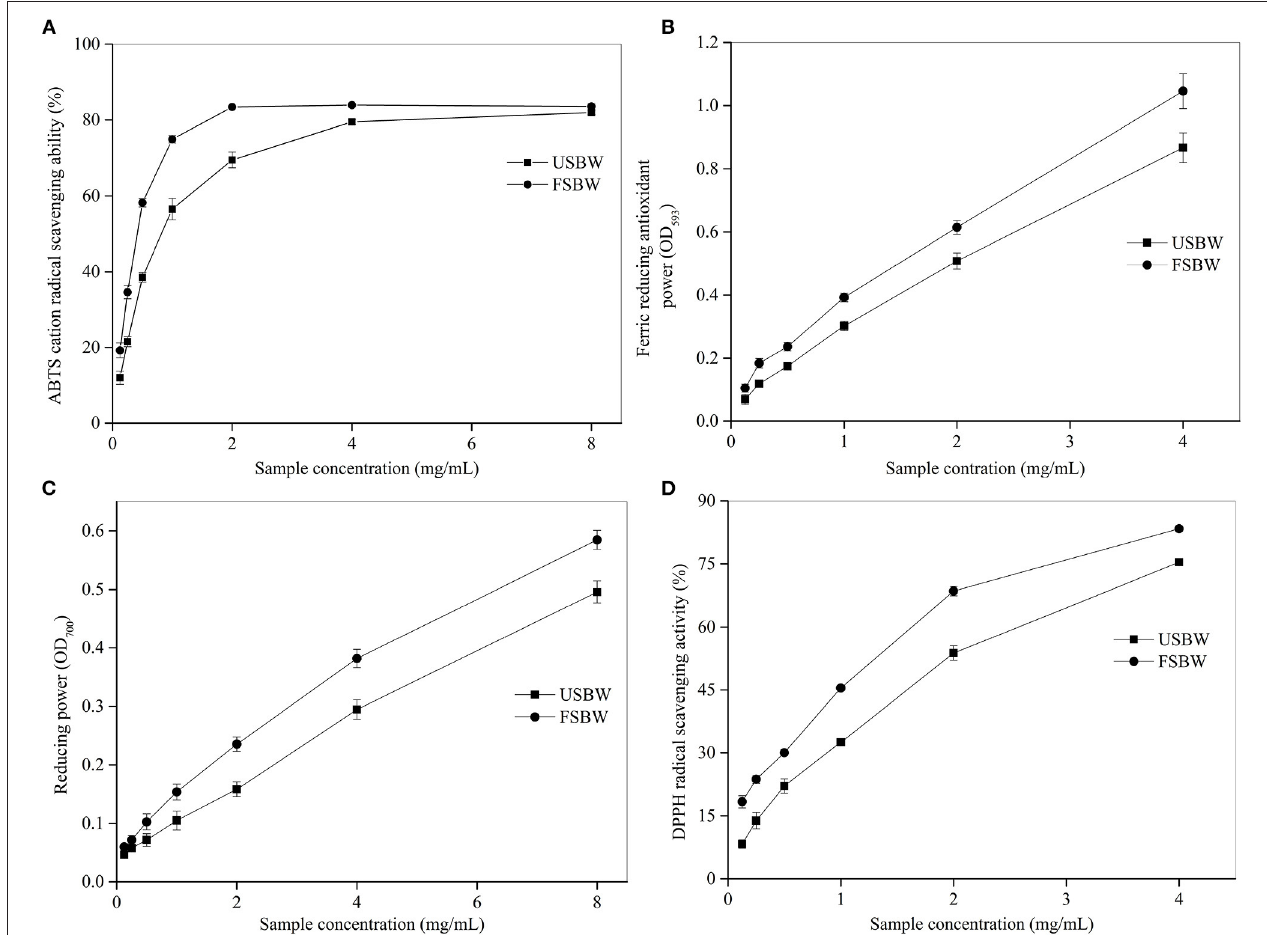
FIGURE 1 | Antioxidant capacity of USBW and FSBW extracts. (A) ABTS · + scavenging capacity; (B) ferric reducing antioxidant power; (C) reducing power; (D) DPPH radical scavenging